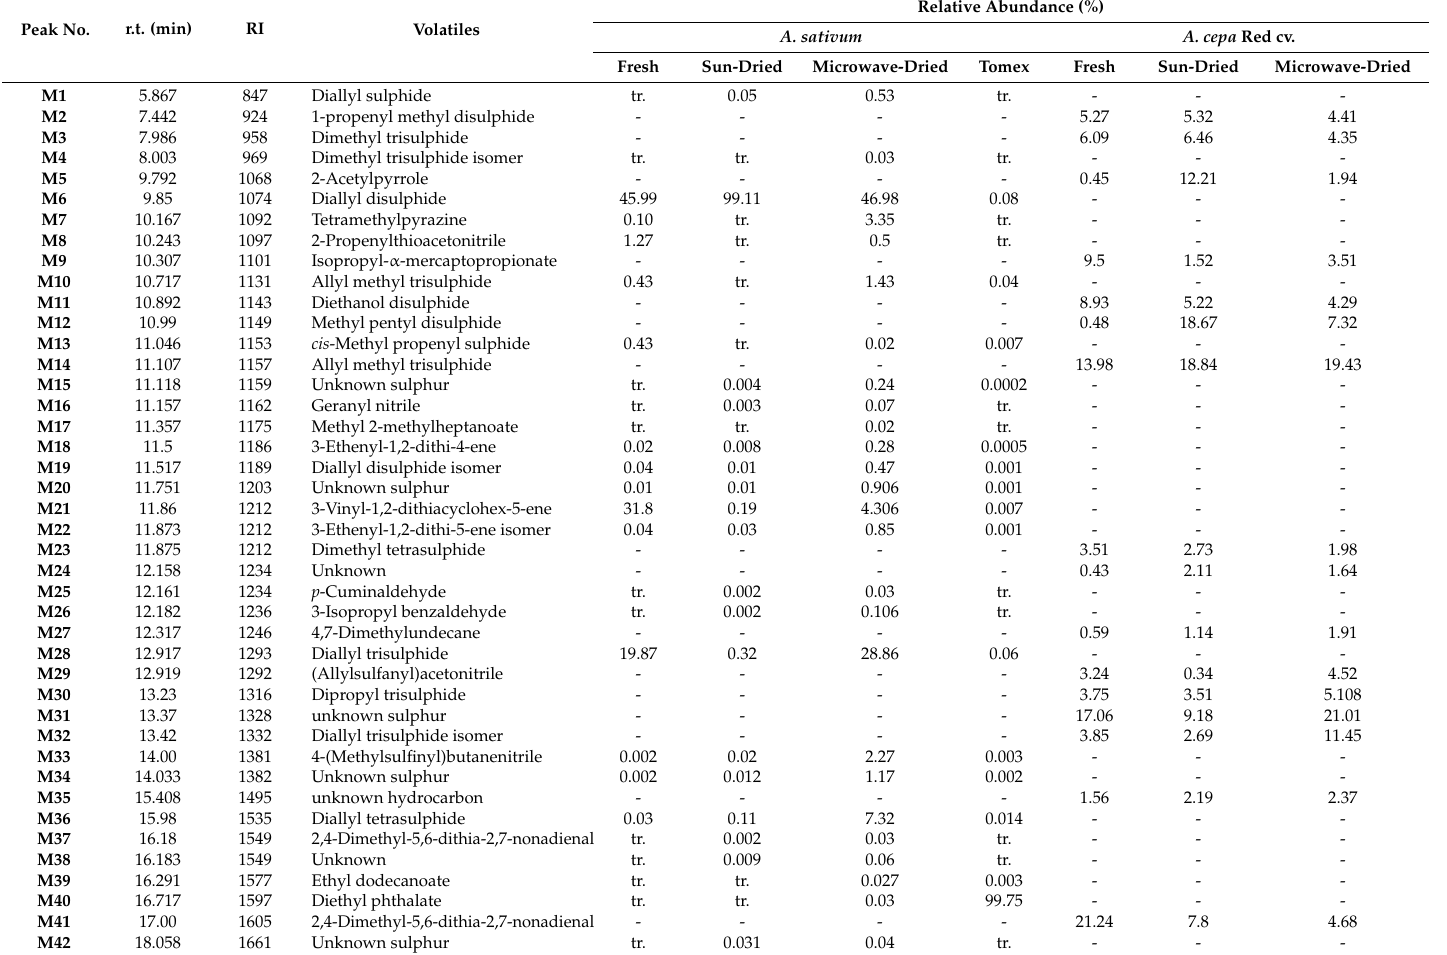
Table 1. Volatiles identified via solid-phase microextraction coupled to gas chromatography mass spectrometry (SPME-GC/MS) analysis of A. sativum and A. cepa red cv. and with amounts expressed as relative percentile (%), n = 3. Retention index (RI) is calculated relative to an alkane series C6–C20 analysed under the same conditions.